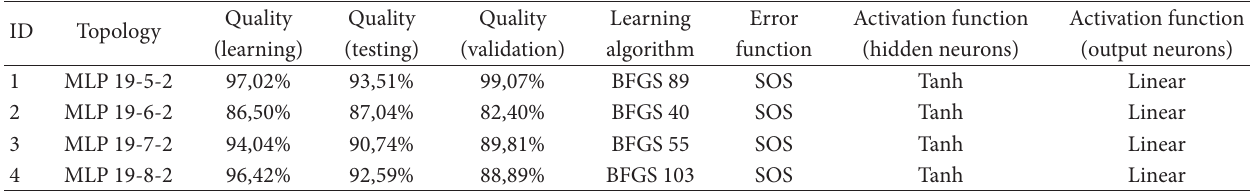
T 1: e results obtained for ANNs classifying E. coli